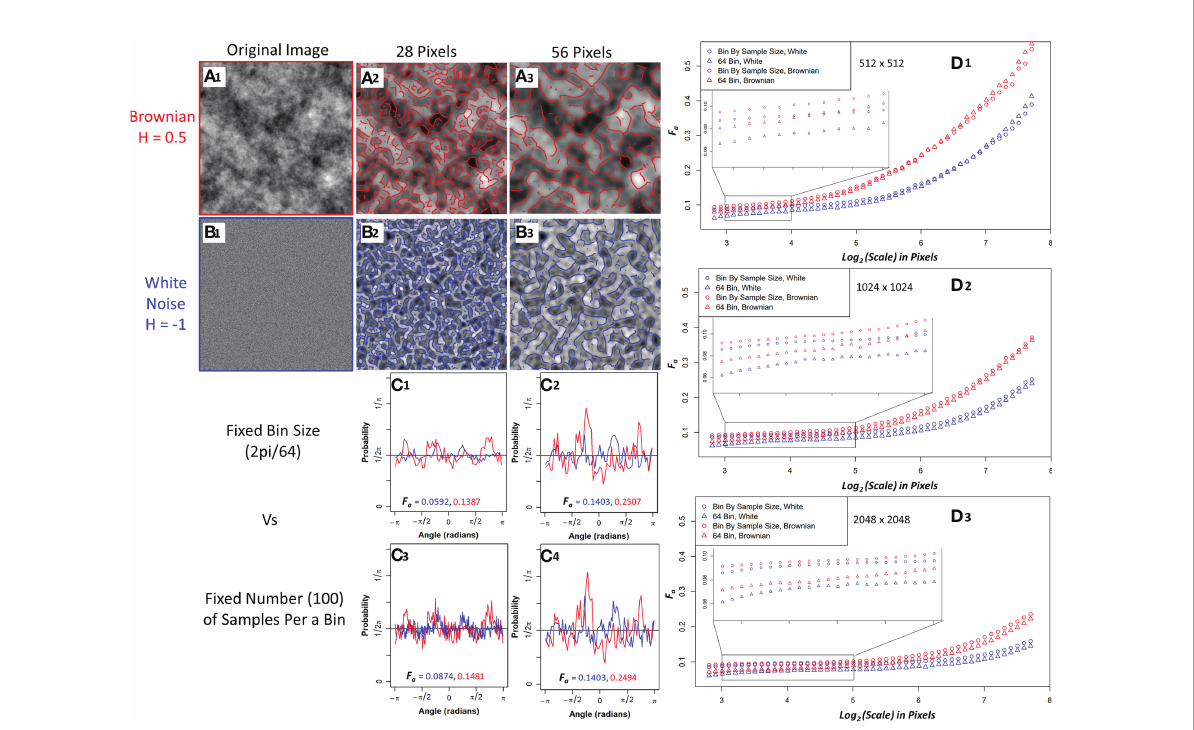
FIGURE 3 Sample Brownian image (A1) and sample white noise image (B1) convolved with a 28-pixel wavelet (A2, B2) and a 56-pixel wavelet (A3, B3) with maxima chains shown in red (Brownian) and blue (white noise). Probability density functions (PDF) with anisotropy factors from two representative size scales using 64 bins to generate the PDF (C1, C2) and fi xing the number of samples (100) per a bin to generate the PDF (C3, C4) . Brownian is shown in red and white noise in blue. Median anisotropy factor vs wavelet scale across 136 images for Brownian (red) and white noise (blue) 512 x 512-pixel images (D1) , 1024 x 1024-pixel images (D2) , and 2048 x 2048-pixel images (D3) with fi xed 64 binning for anisotropy factor calculation (Triangle) and 100 samples per a bin calculation (Circle). Inset graph is a zoomed in view of anisotropy factor vs scale within the enclosed